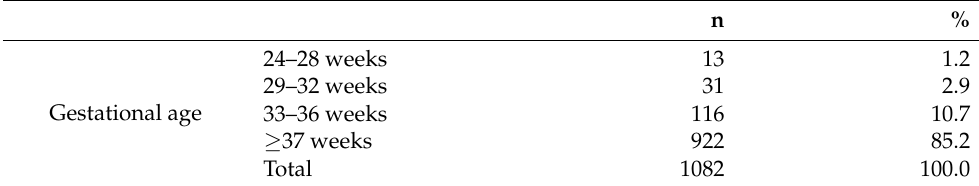
Table 5. Number of preterm births and their gestational